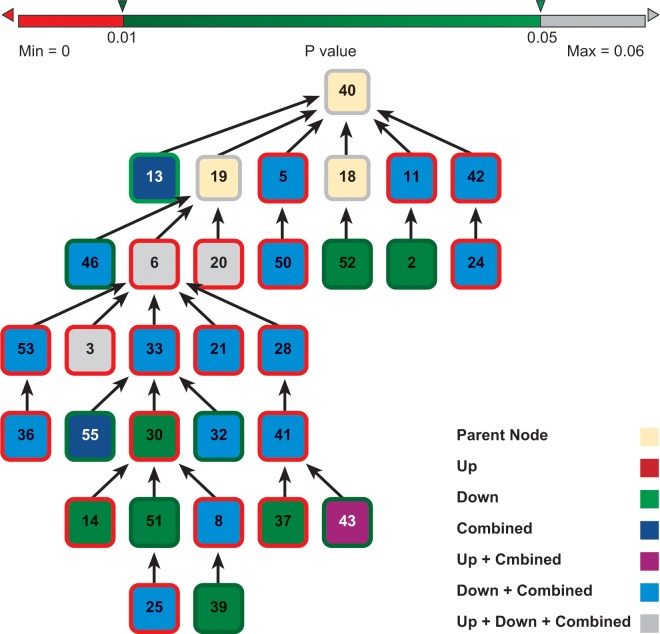
GO Cellular Component Trees (Benjamini-corrected p-value cutoff = 0.05) for the “Eutheria-conserved” Alarm_Pheromone Genes” Human Orthologs.This figure shows the Cellular Component tree. “Eutheria-conserved” defined as in Fig 4 legend. Nodes with red bounds are GO terms with p-value (Benjamini p-value) < = 0.01. Nodes with red bounds are GO terms with p-value < = 0.01. Nodes with various green bounds are nodes with p-value between 0.01 and 0.05. Nodes with white bounds (or no bounds as it is the same as the background color) are not themselves enriched but are parents of enriched terms in the GO hierarchy. Separate GO analysis are done for all the up-regulated “Vertebrate-conserved” Alarm_Pheromone Genes” Human orthologs (“Up”), all the down-regulated ones (“Down”), and all regardless of regulation (“Combined”). The results are indicated by the colors of the node faces as follows: GO category enriched in the up-regulated subset only is red; GO category enriched in the down-regulated subset only is green; GO category enriched in the complete set is deep blue; GO category enriched in the up-regulated subset and the complete set is purple; GO category enriched in the down-regulated subset and the complete set is light blue; GO category enriched in both subsets and in the total set is gray. The exact names for these indexed GO terms are in Table 4 and in S2 Table. Corresponding information about the “mouse-and-human-conserved” and “vertebrate-conserved” gene sets is found in S2 Table.